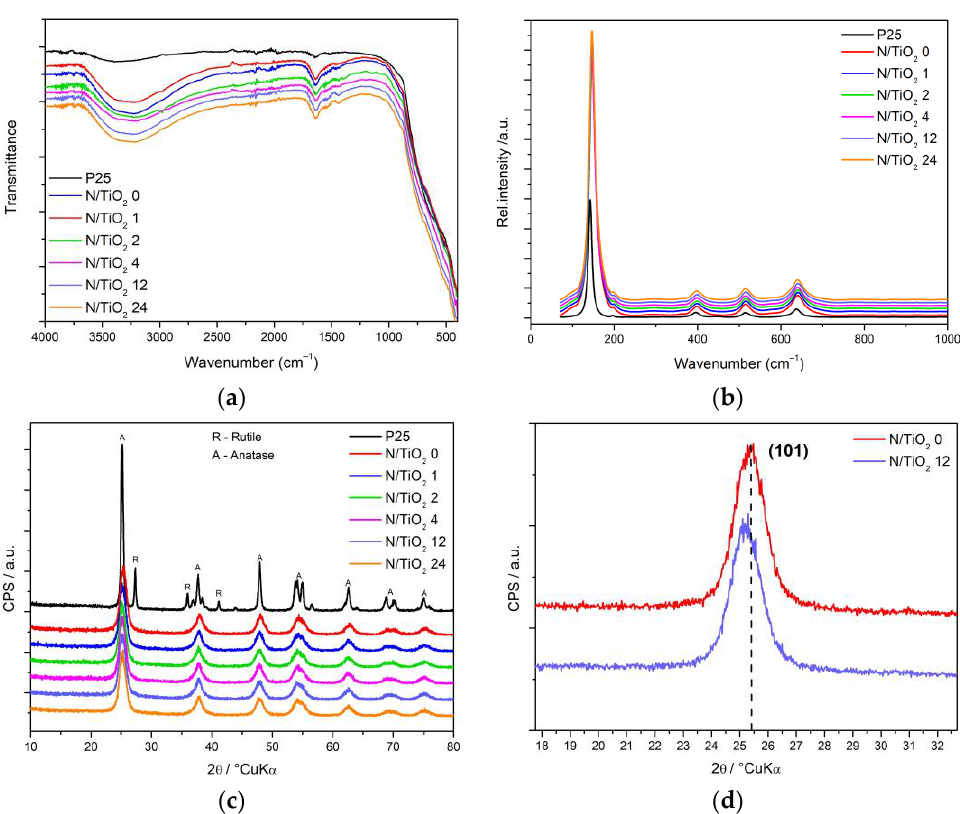
Figure 3. ( a ) FTIR spectra of N/TiO 2 materials and Degussa P25; ( b ) Raman spectra; ( c ) X-ray diffraction patterns, and; ( d ) X-ray diffraction peak (101) of the N/TiO 2 materials synthesized at 0 and 12 N/Ti molar ratios. Table 3. Specific surface area, pore-volume, and pore size of N/TiO 2 materials and Degussa P25.